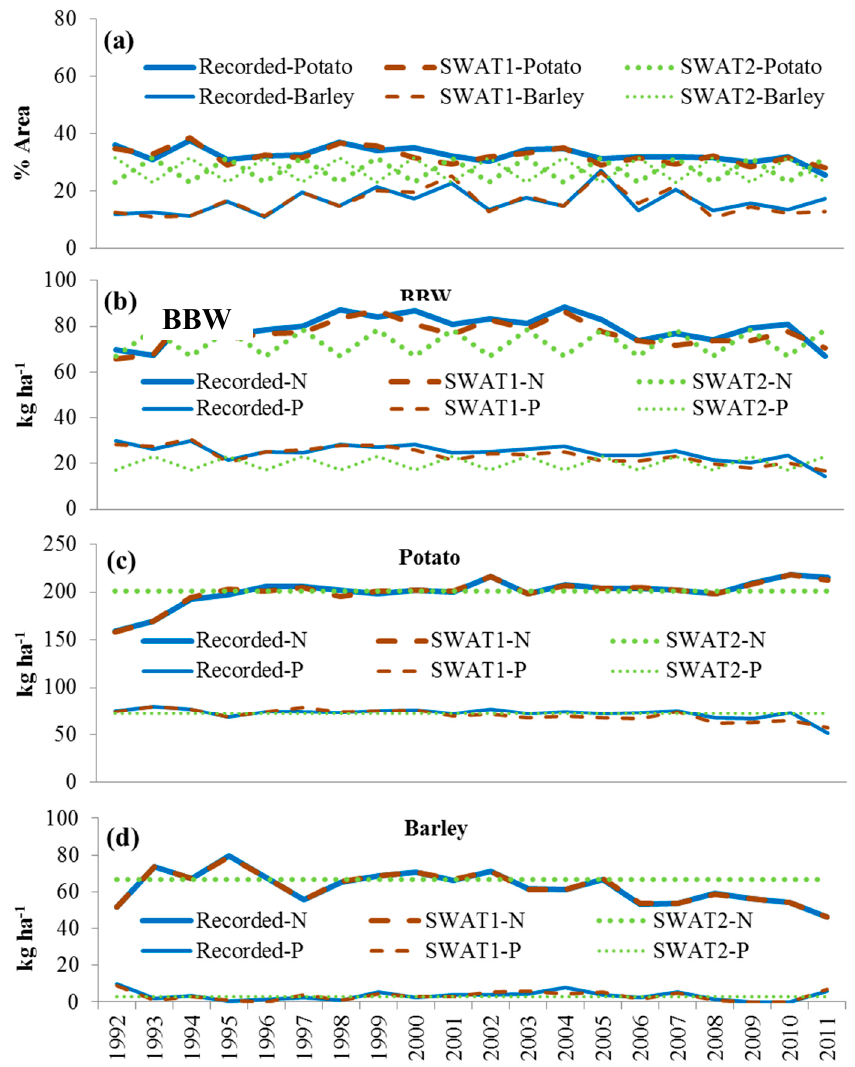
Figure 5. ( a ) Input percentage areas of potato and barley and annual application rates of N and P for ( b ) the entire watershed, and ( c ) potato and ( d ) barley fields compared with records from 1992 to 2011 in the